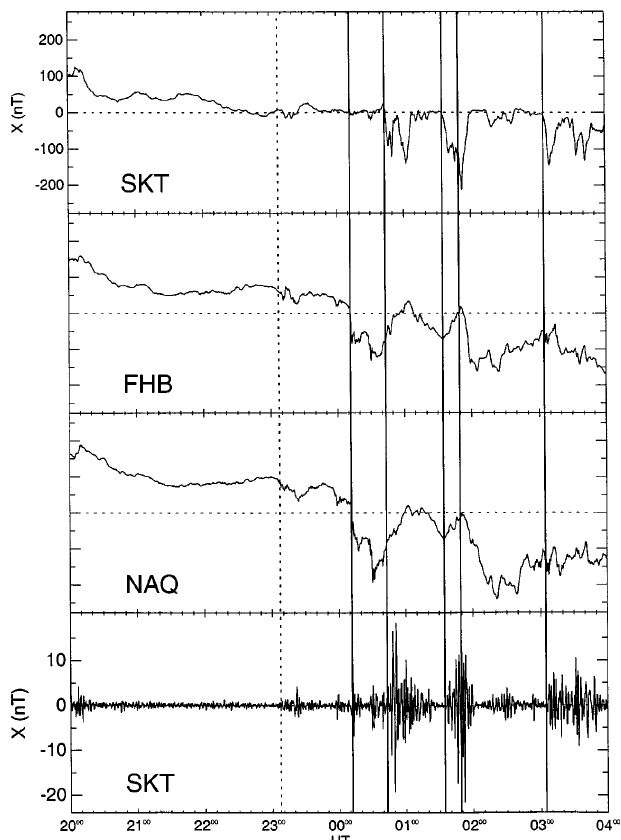
Fig. 3. Ground magnetograms from the Greenland array. X com- ponent magnetograms from a subset of west coast stations for the interval 20:00 UT 10 May – 04:00 UT 11 May, 1998, are displayed. A bandpass filtered (200–20 s) trace from SKT is included in the bottom panel . Substorm expansion phase onset/intensifications are marked with solid vertical lines . The dashed vertical line at 23:08 UT indicates a